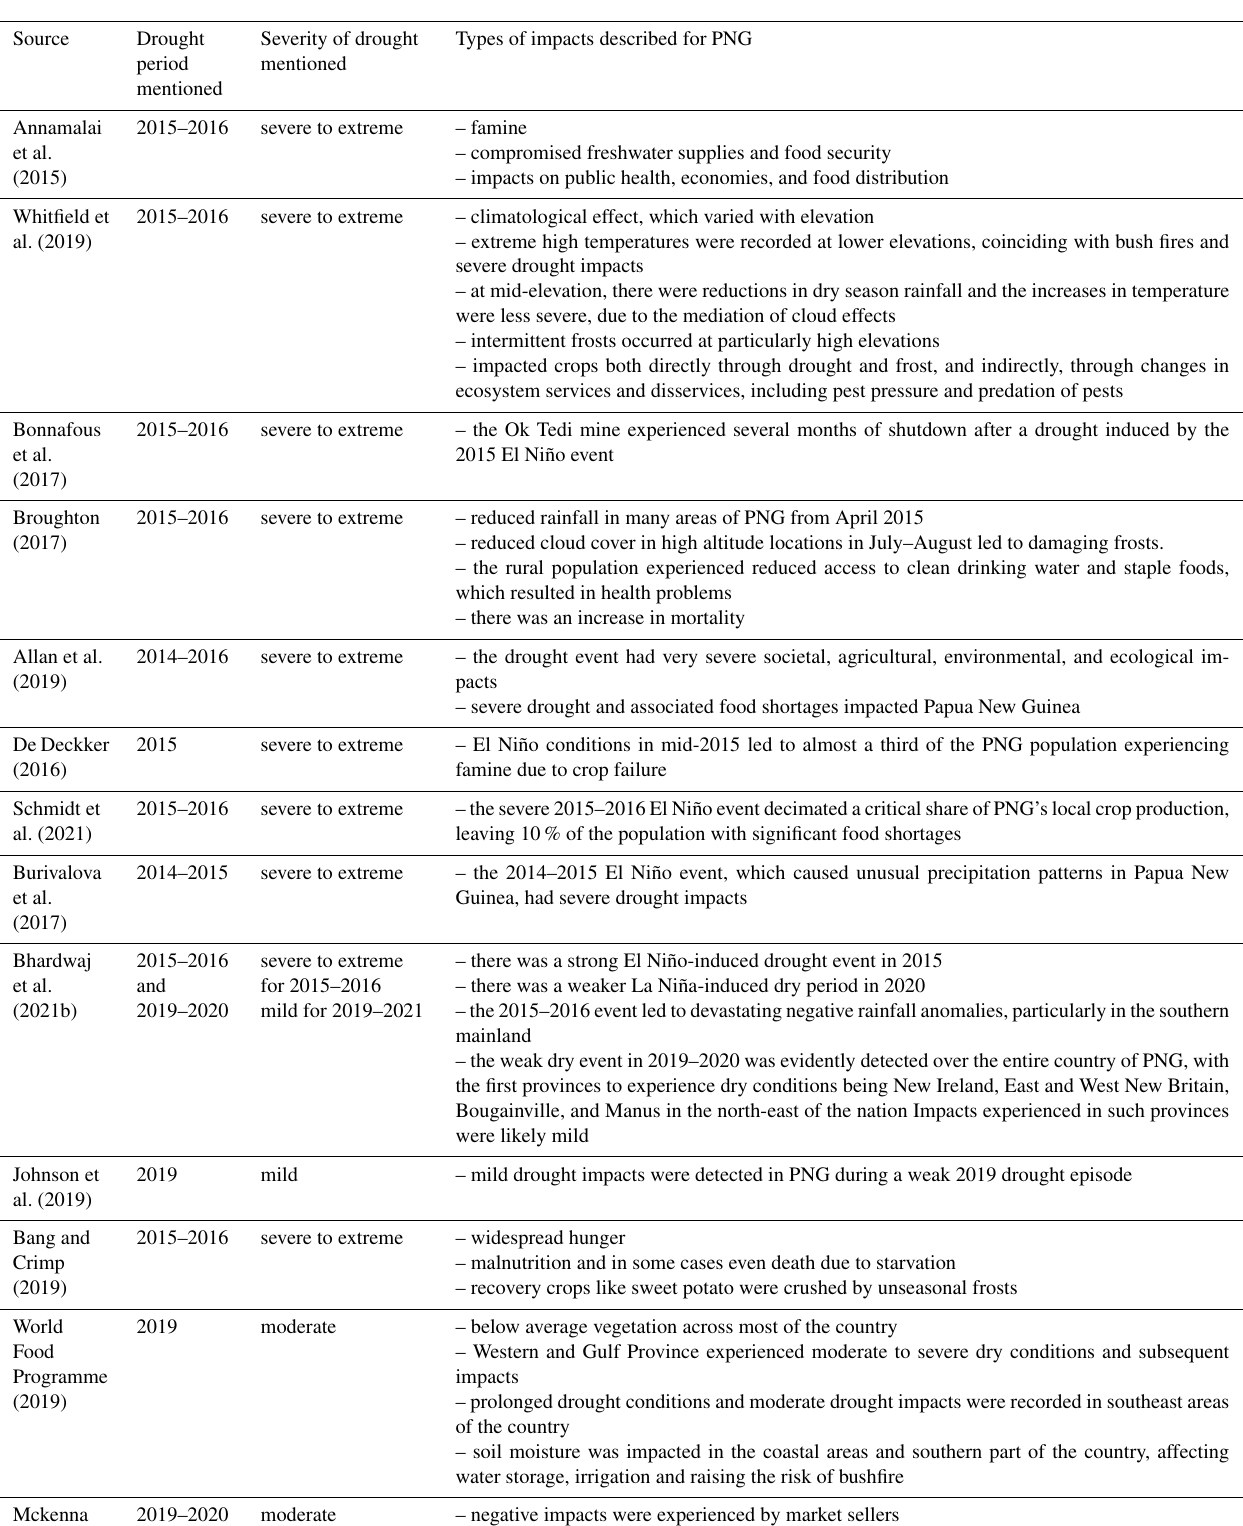
Table 8. Literature sources used as a ground truth. The source is listed and described with the types of impacts listed in the sources